Question: In one sentence, what is this figure communicating?
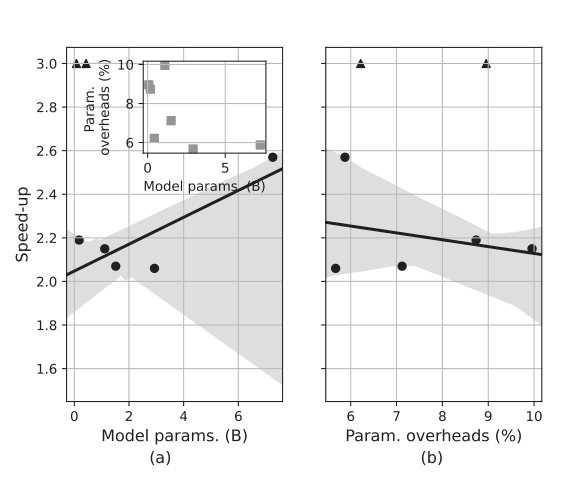
Answer: Speed-up, i.e., the minimum of (theoretical) same- quality speed-up and 3× for three-token models, with (a) model sizes and (b) parameter overheads. Results are shown for pairwise evaluation on the sentence-completion bench- mark. Only points below 3× speed-up were used to plot the regression line (shown with 95% confidence intervals). Pa- rameter overheads with model sizes are shown in the inset.